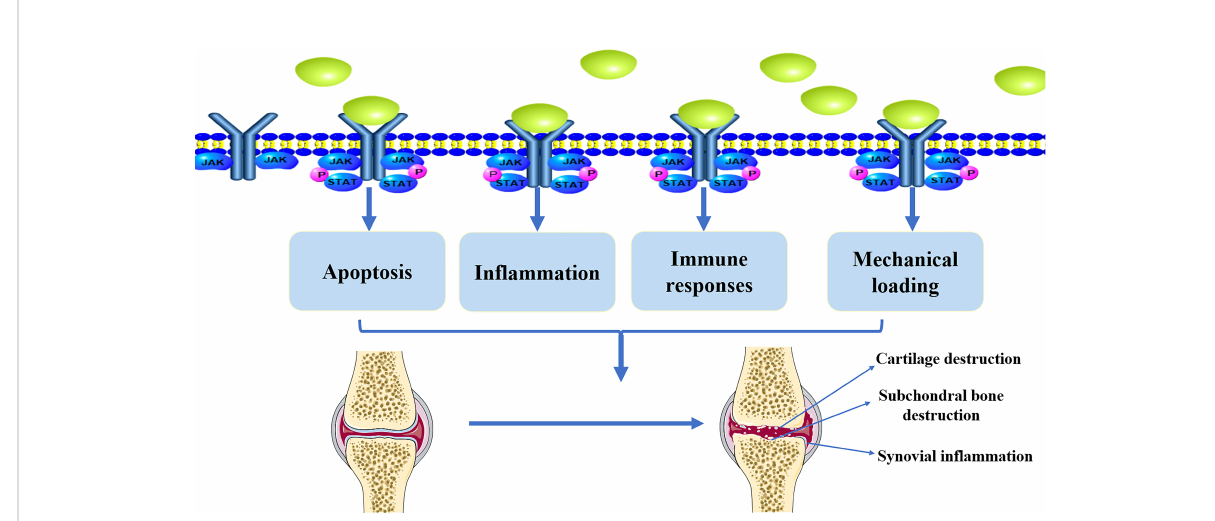
FIGURE 2 The implication of JAK/STAT pathway in the pathological development of OA. Active JAK/STAT pathway may induce the pathological development of OA by regulating in fl ammation, immune responses, mechanical loading, and apoptosis, leading to cartilage destruction, subchondral bone destruction, and synovial in fl